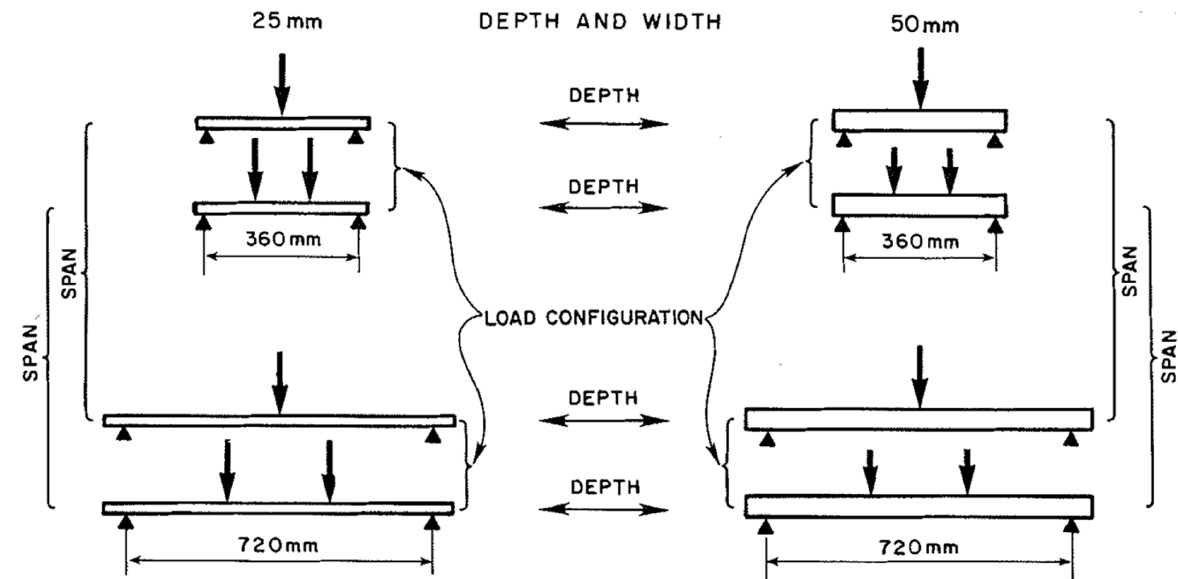
Figure 45. Various configurations of the load applied to the specimens shown in Figure 46. From [102].